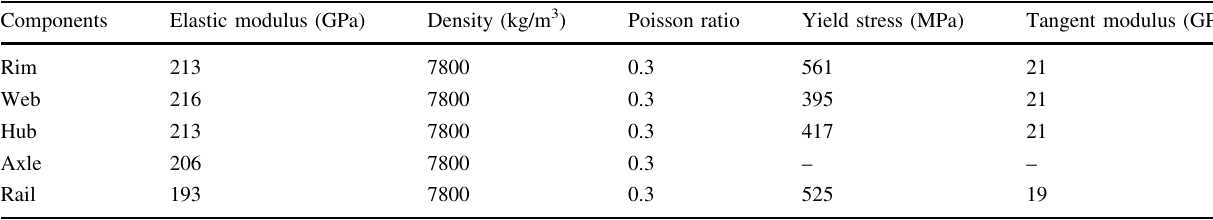
Table 1 Material parameters of components of the wheel–rail system Components